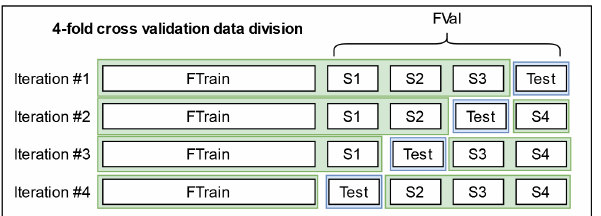
Figure 6. A four-fold cross-validation schema used for the internal testing of different pipelines using the 2019 or 2020